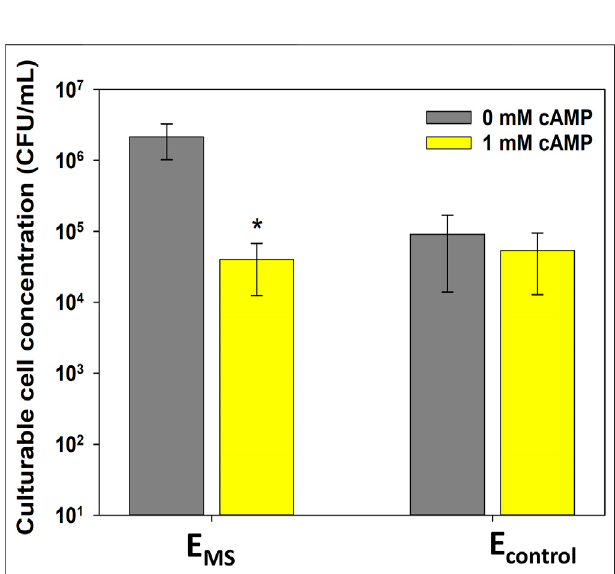
FIGURE 3 | Percentage of viable cells after 60 min of treatment with 11.2 mg/L as Fe of ferrate (E FS ) or 2.5 mg/L as Cl 2 of monochloramine (E MS ), or water (E control ). Each data point represents an average of at least triplicate samples. Error bars represent one standard error of at least triplicate samples.